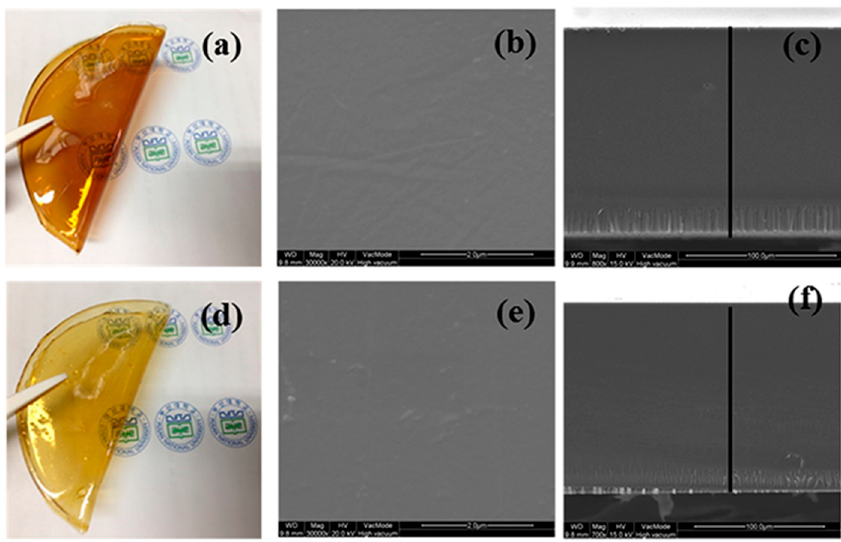
Figure 6. Photographs, surface, and cross-sectional SEM images of the cardo-PES-QA ( a – c ) and cardo-PES-IM ( d – f ) membranes, respectively.